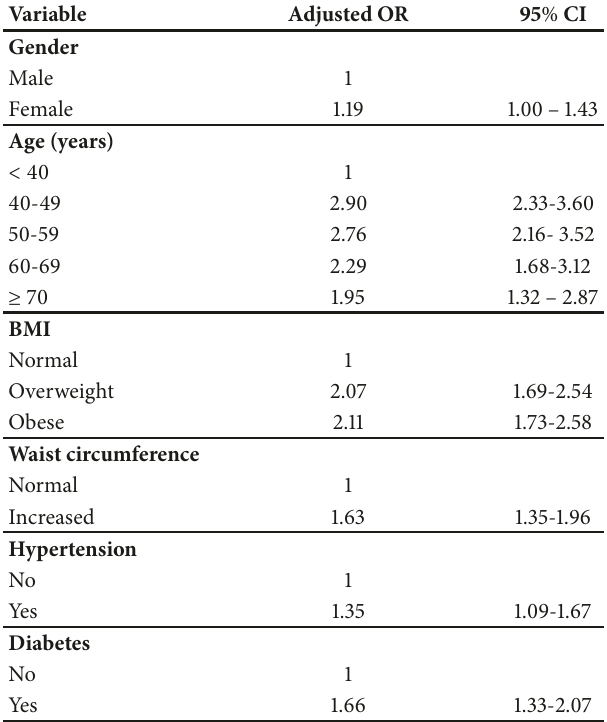
Table 5:Adjusted odds ratios andtheir95% Clfor highLDL-Cusing multivariate logistic regression, Jordan